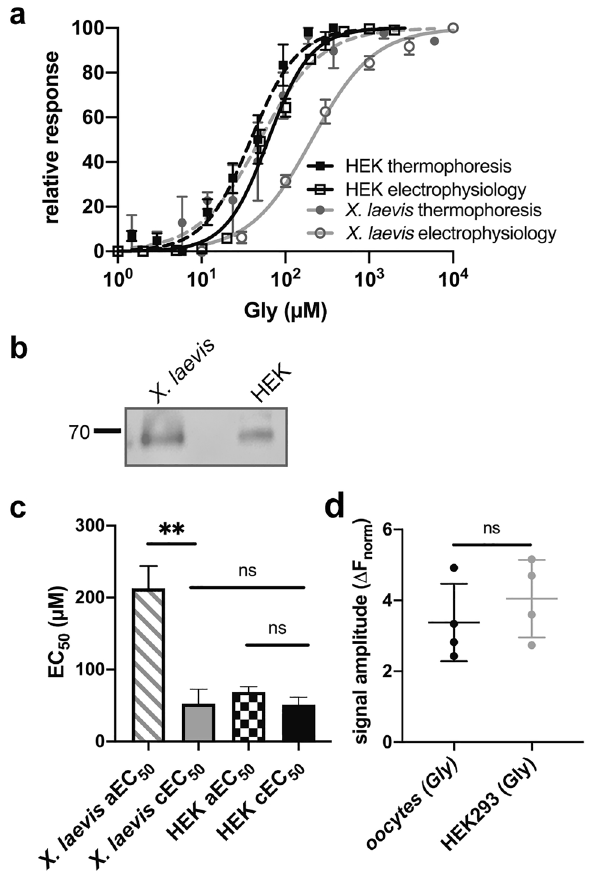
Figure 3. Functional analysis of α1-GFP GlyR nanodiscs from HEK293 cells and X. laevis oocytes. ( a ) Dose– response relationship of α1-GFP GlyR obtained by MST experiments and electrophysiological recordings from HEK293 cells and oocytes. MST data points were inversely normalized for better comparison with dose–response curves obtained from electrophysiological measurements. Data are shown in mean ± SEM. ( b ) Western blot of SMA-copolymer solubilized GFP-GlyR α1 obtained from the membrane fractions of oocytes and HEK293 cells, show a single band at the calculated molecular weight below 70 kDa. Western blot image was cropped, indicated by a grey cropping line. ( c ) Electrophysiological experiments obtained from oocytes and HEK293 cells revealed aEC 50 values 212.9 ± 21 µM and 68.8 ± 7.4 µM, respectively. cEC 50 values of 52.6 ± 40.8 µM ( n = 4) and 40.9 ± 13.4 µM ( n = 4) obtained from oocytes and HEK293 cells showing no significant difference ( p = 0.41). The aEC 50 obtained from is significantly higher ( p < 0.01) than the measured cEC 50 , while the aEC 50 and cEC 50 obtained from HEK293 cells show no difference ( p = 0.23). Error bars represent SEM between independent experiments. ( d ) Signal amplitudes obtained from MST experiments reveal no differences between HEK293 cells (signal amplitude = 4.04 ± 1.09) and oocytes (signal amplitude = 3.38 ± 1.09; p = 0.41, n = 4). Data are shown in mean ± SD. Unpaired two-side t test for